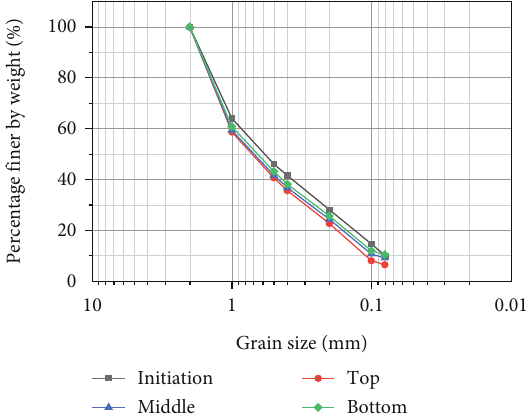
Figure 12: Test number 5 particle grading variation curves before and after